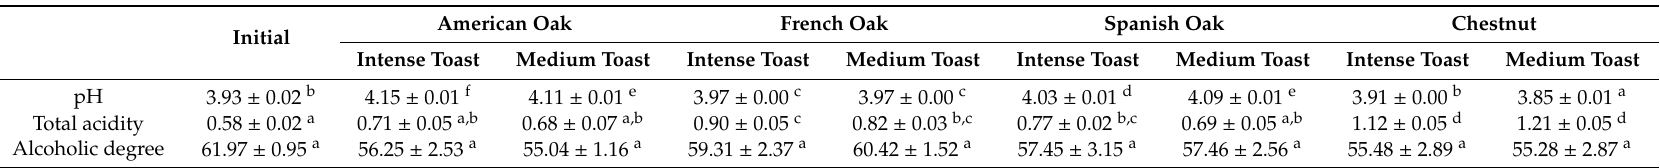
Table 1. pH, total acidity (g / L Tartaric acid) and alcoholic degree (% Alcohol by Volume, ABV) of distillates ageing in barrel of American, French and Spanish oak, and Chestnut.